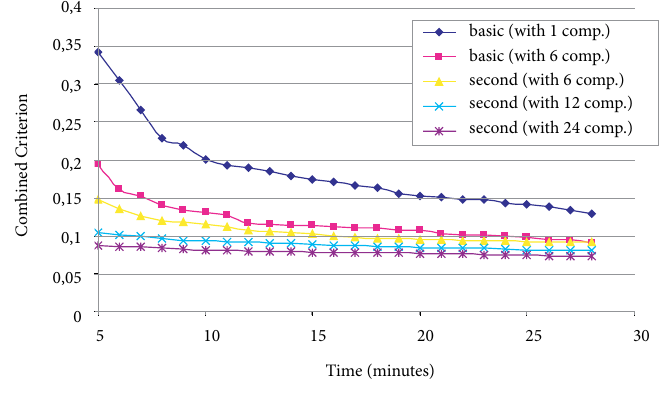
Fig. 4. Average values of the combined criterion (all DMs in all the trials)